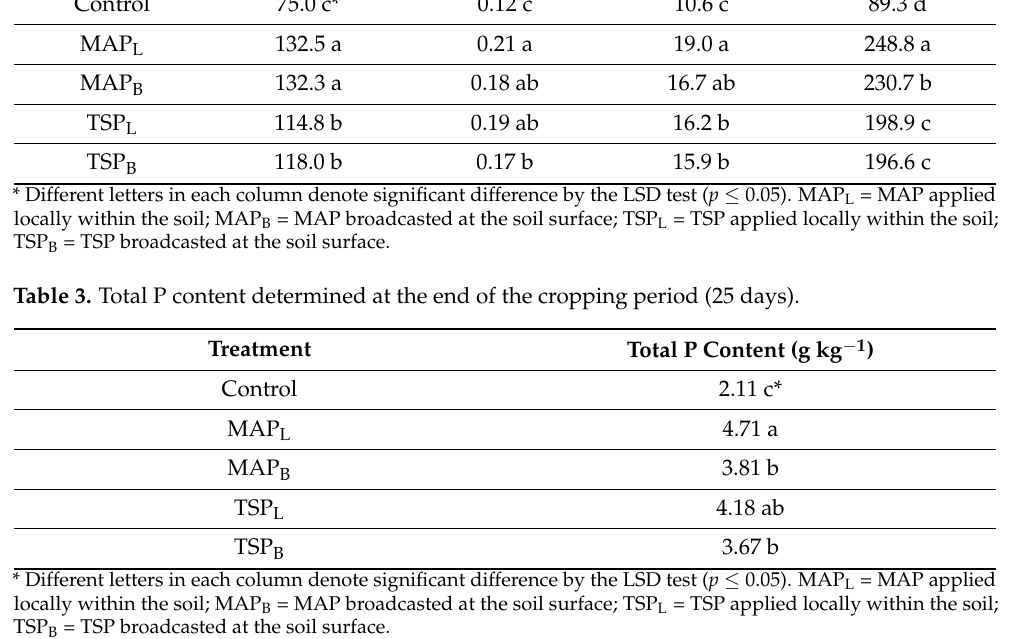
Table 2. Soybean root growth, superficial area (cm 2 ), root tip number, volume (cm 3 ), and root length (cm) at the end of the cropping period (25 days).